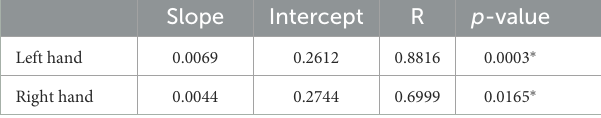
recursive validation on the last 15 s of data at every step for pseudo-online REW-NPLS).